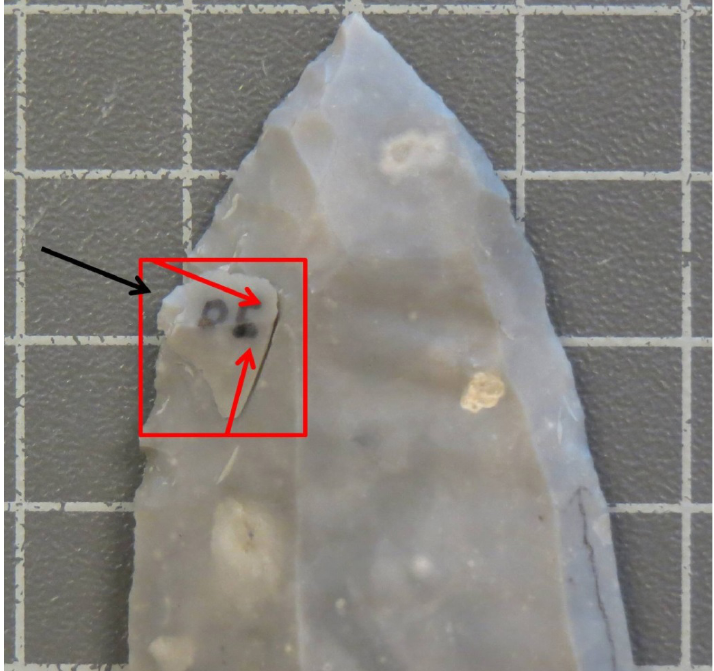
Figure 16. Blade-point 4.3, flake d5 with the black arrow indicating direction of removal blow and the red arrows indicating dorsal scar pattern (photograph by the author). Gridlines on this image are 10 mm